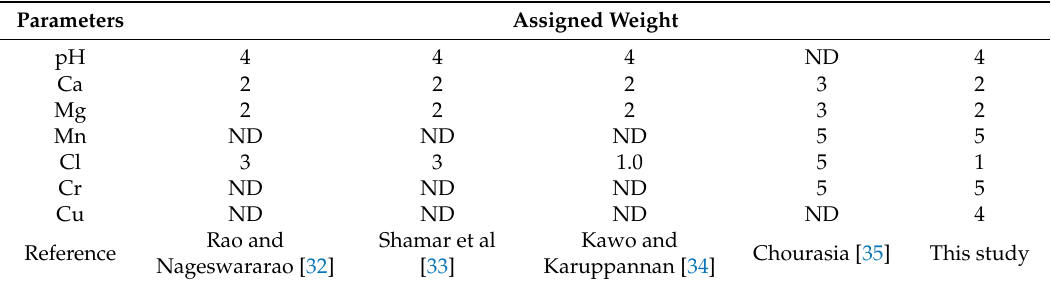
Table 1. The assigned reported weight for water quality parameters in this